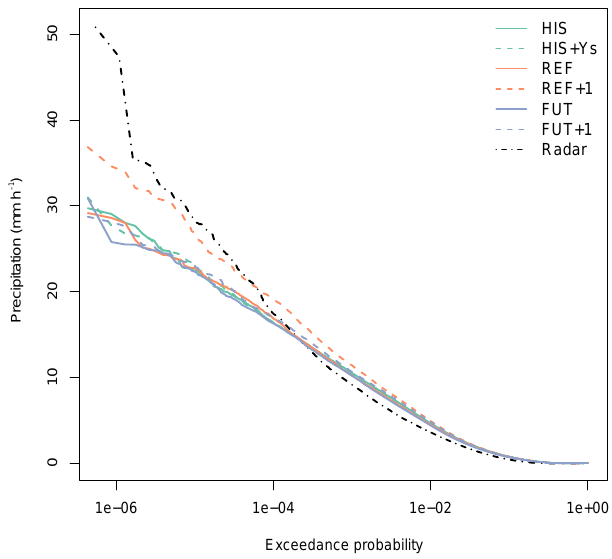
Figure 9. Distribution of hourly precipitation (mmh − 1 ) for each of the experiments and radar data, averaged over the 14 days that have radar data available.